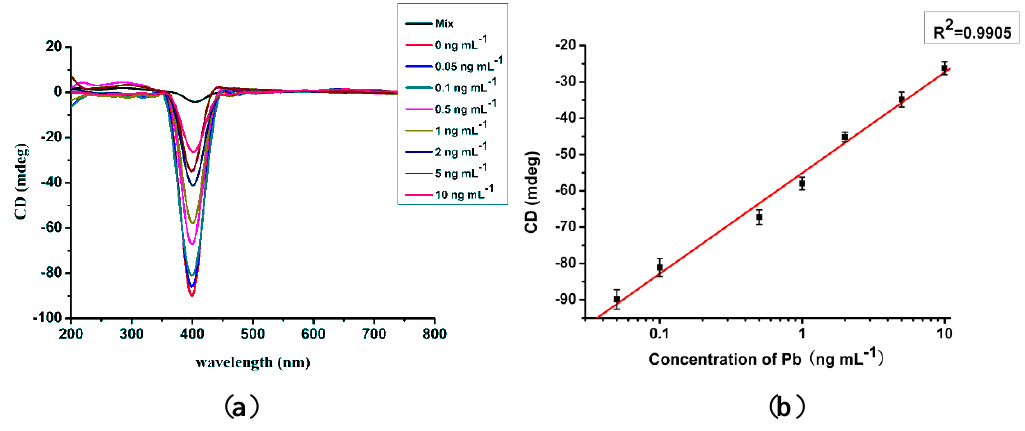
Figure 3. ( a ) CD spectrum under different concentrations of Pb 2+ (0, 0.05, 0.1, 1, 2, 5, and